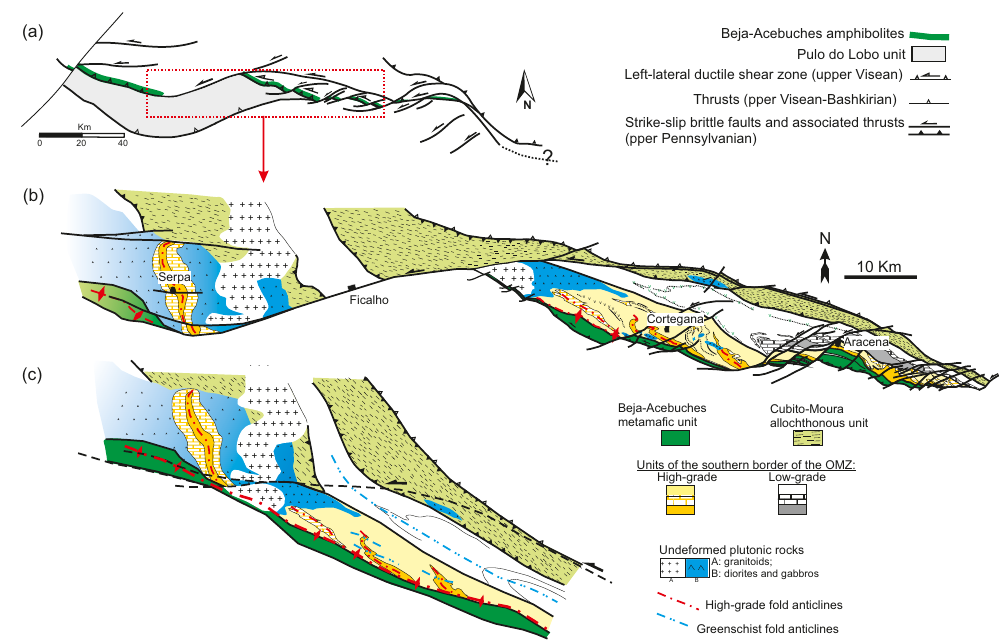
Figure 9. (a) Schematic map of the main late Variscan faults affecting the OMZ–SPZ boundary. Compare with Fig. 1c for location. (b) Map of the central part of the OMZ–SPZ boundary, showing the main Ficalho fault and the set of shorter faults affecting the Aracena–Cortegana sector. (c) Reconstruction of this central part before the brittle faulting.